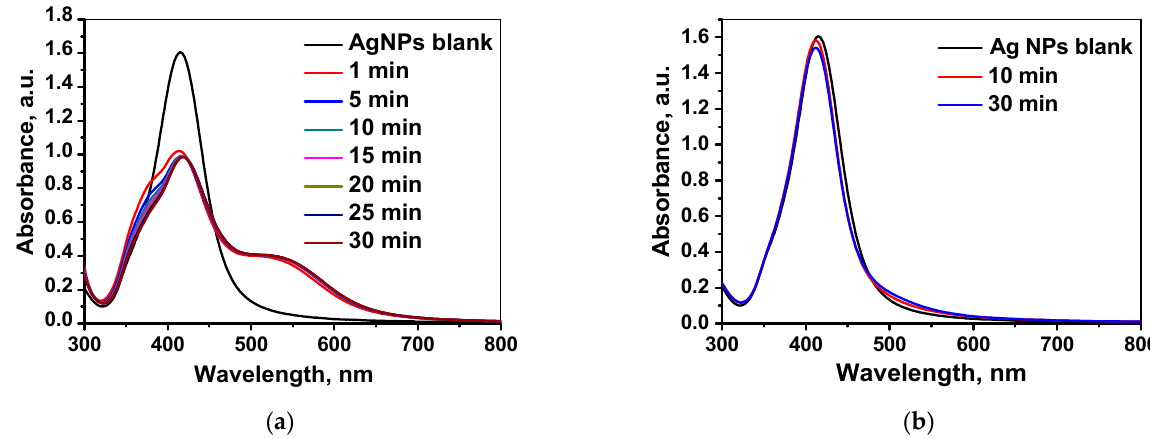
Figure 3. Evolution of UV-Vis absorbance spectrum of Ag/Raff NPs ( a ) upon addition of 5 × 10 − 5 mol L − 1 Cr(VI), in situ reduced to Cr(III) by ascorbic acid at pH 4, and ( b ) upon addition of 5 × 10 − 5 mol L − 1 Cr(III) at pH 4.